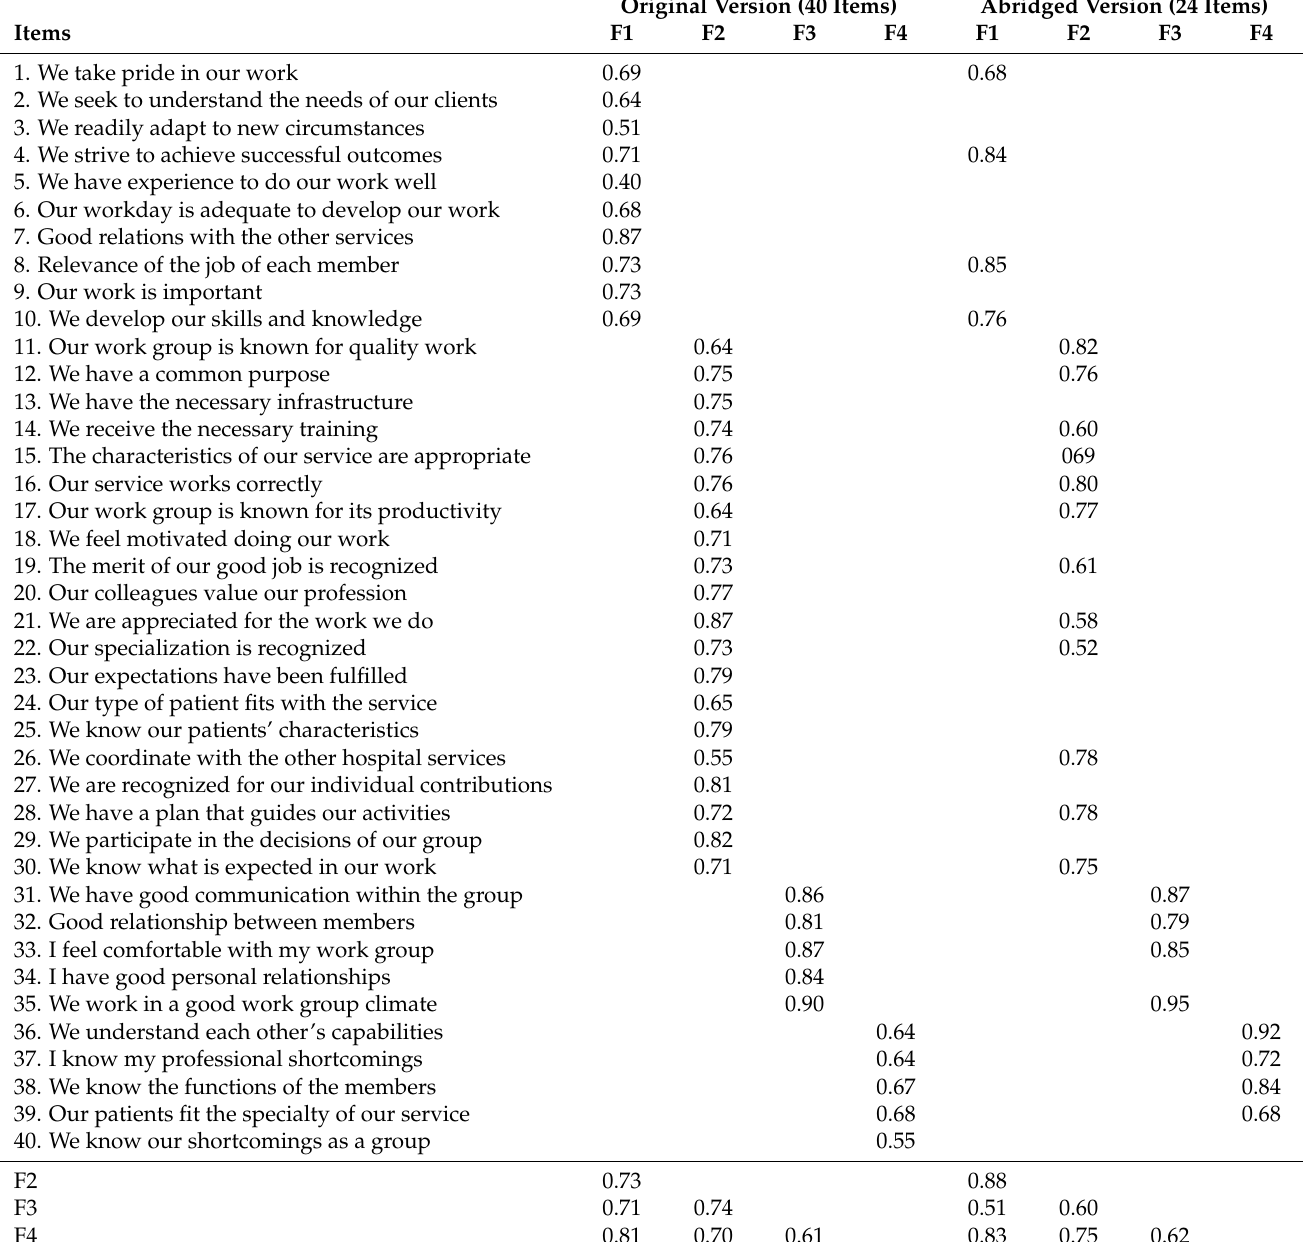
Table 5. Comparison of factor loadings and factor correlation matrix of both scale